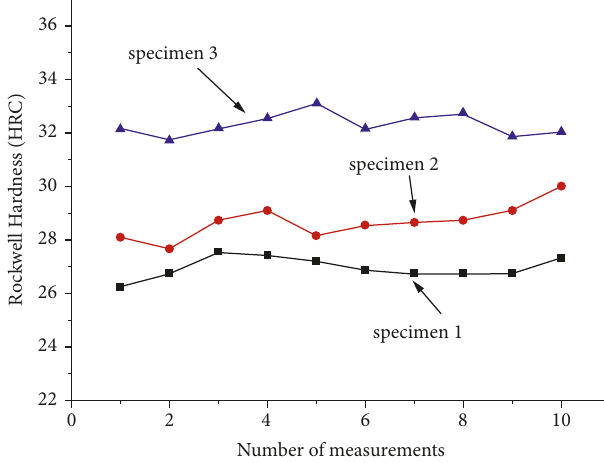
Figure 6: Rockwell hardness of the three test specimens. Table 4: Tensile strength of the three test